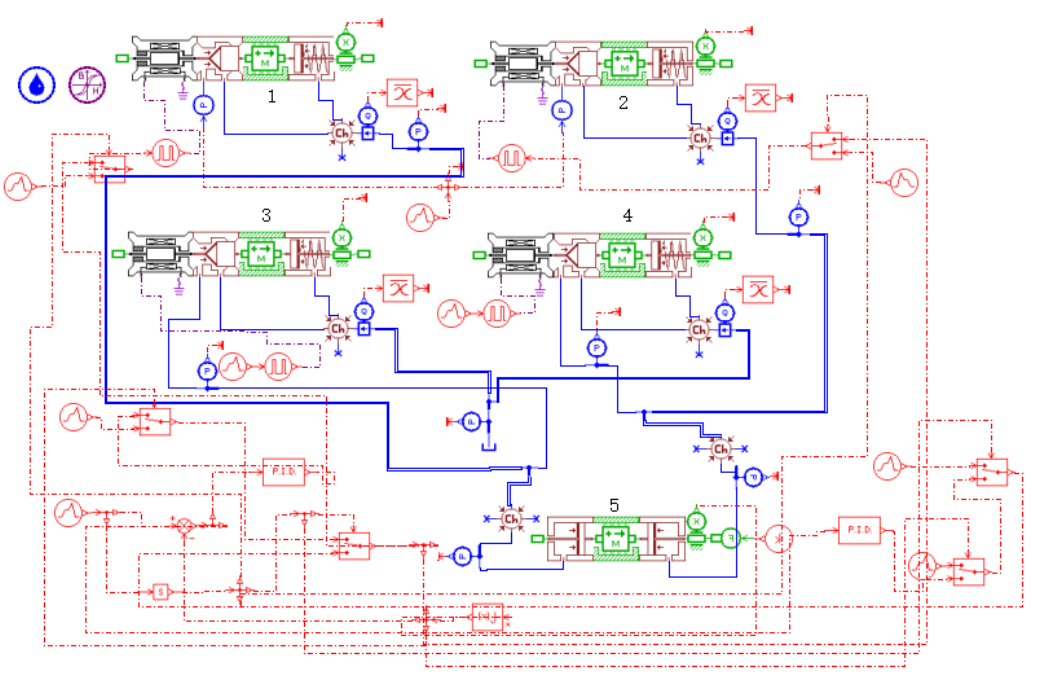
Figure 13. Simulation model of the belt conveyor digital hydraulic propulsion system.